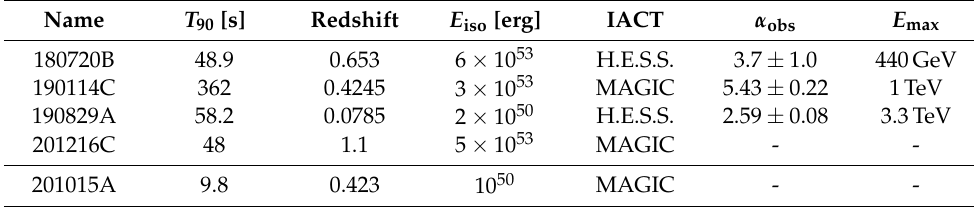
Table 1. Summary of the main properties of the GRBs detected in the VHE range. GRB 201015A is included due to the strong evidence reported in [75] and is described in Section 4.4. The isotropic energy E iso is calculated in the 50–300keV range for GRB 180720B, 1–10 4 keV for GRB 190114C, and 10–10 3 keV for GRB 190829A and GRB 201216C. The spectral index α obs is reported for the observed time-integrated spectrum (after absorption due to the EBL) over the whole observation window assuming a power-law